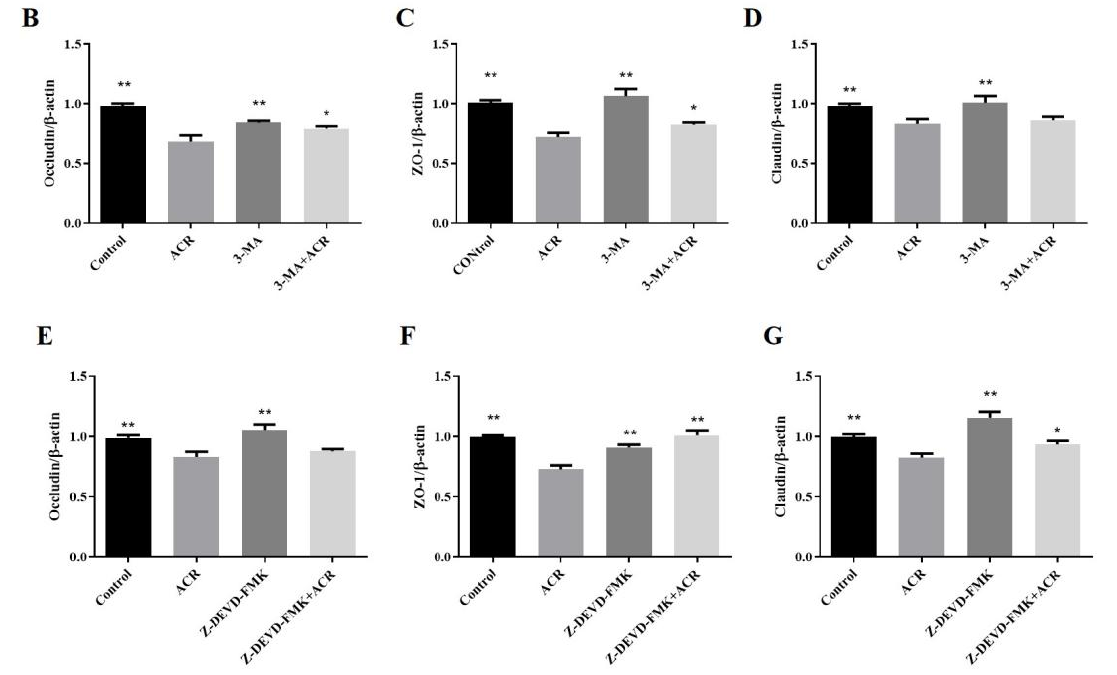
Figure 8. Autophagy and apoptosis inhibitor attenuated TJ. ( A ) The protein levels of occludin, claudin, and ZO-1, “+” indicates addition of acrolein or PSG-1 and “-” means not added. ( B – G ) Relative intensities of these proteins. Values are means ± SD ( n = 3), * p < 0.05, ** p < 0.01 compared with the acrolein group.